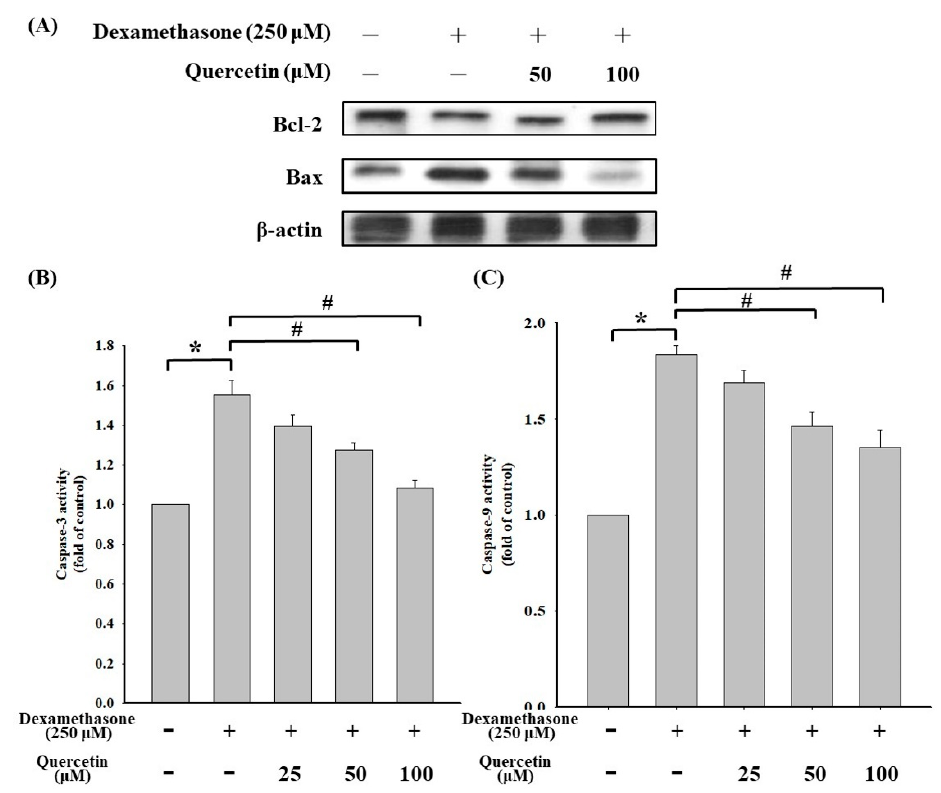
Figure 5. ( A ) E ff ect of quercetin on apoptotic signaling protein in dexamethasone-treated C2C12 myotube cells. The cells were cotreated with or without 50 and 100 µ M quercetin in the presence of 250 µ M dexamethasone for 24 h. Cell lysates were collected and blotted using specific antibodies, including Bcl-2 and Bax, and then subjected to Western blot analysis as described in the Materials and Methods section. Each lane of protein signaling was normalized to β -actin. ( B ) E ff ect of quercetin on caspase-3 protein in dexamethasone-treated C2C12 myotube cells. The cells were cotreated with or without 25, 50, and 100 µ M quercetin in the presence of 250 µ M dexamethasone for 24 h ( C ) E ff ect of quercetin on caspase-9 protein in dexamethasone-treated C2C12 myotube cells. The cells were cotreated with or without 25, 50, and 100 µ M quercetin in the presence of 250 µ M dexamethasone for 24 h ad then subjected to Western blot analysis as described in the Materials and Methods section. Each band was quantified using ImageJ software. Values represent the mean ± SD (n = 3). Significant di ff erences were determined using Dunnett’s test (* p < 0.05, compared with the untreated group; # p < 0.05, compared with the dexamethasone-treated group).